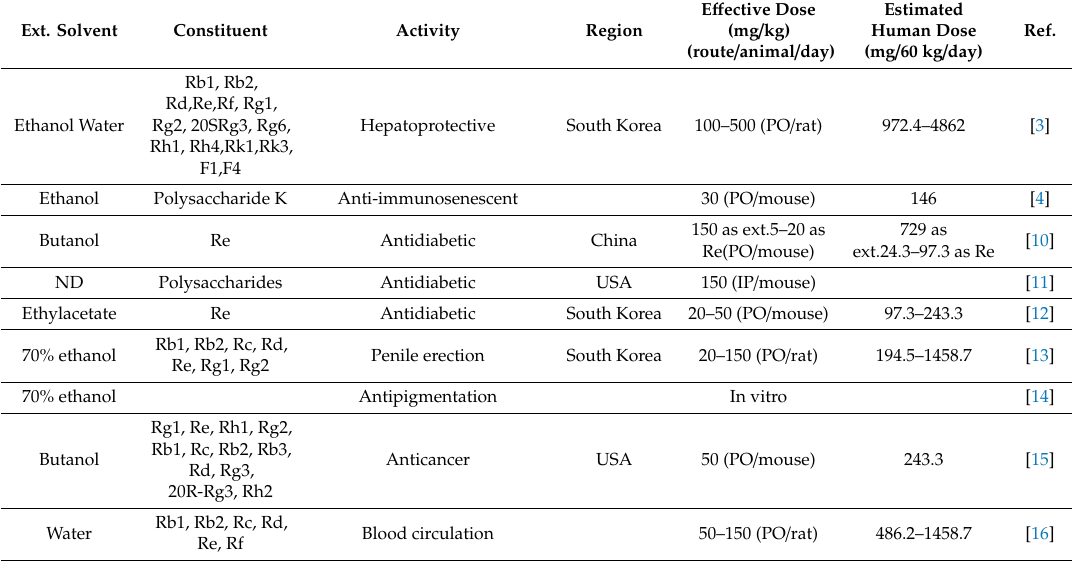
Table 1. Chemical constituents and pharmacological activities of ginseng berry extracts reported in previous